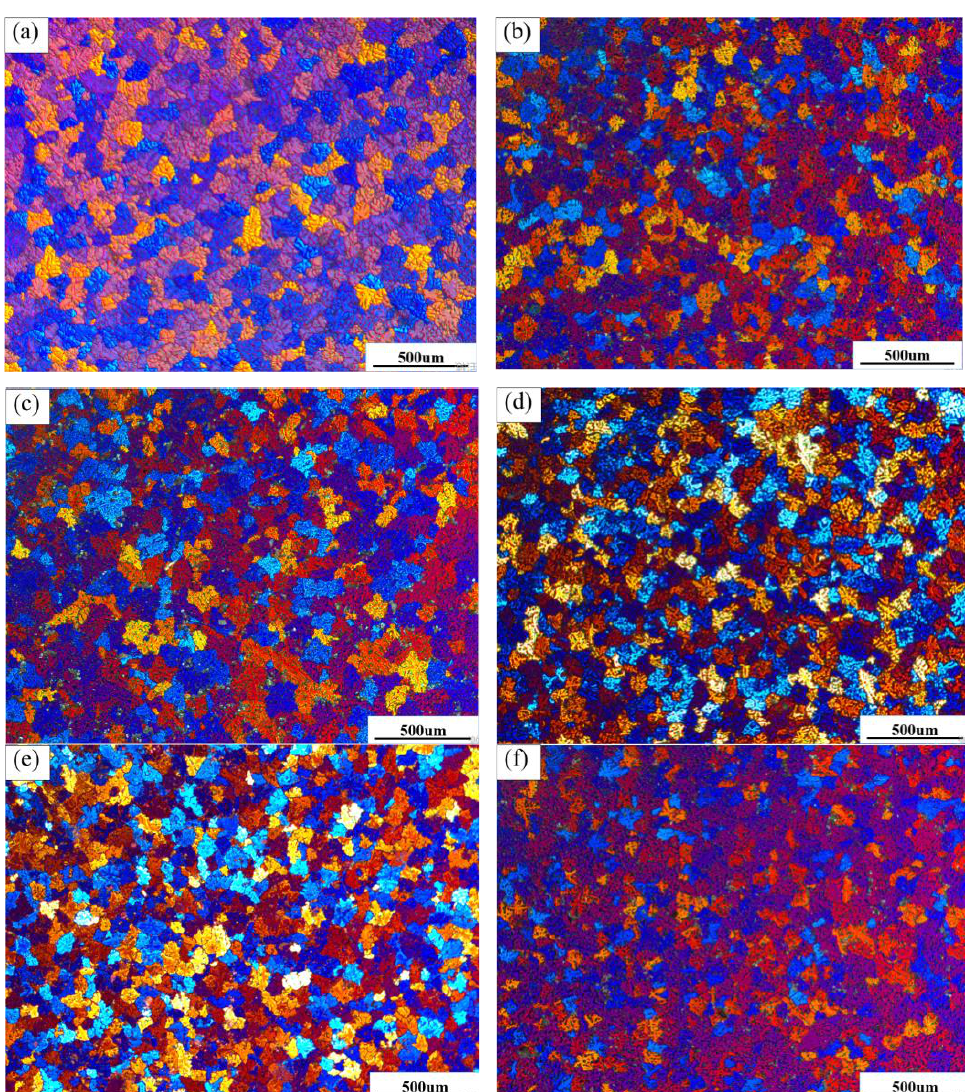
Figure 1. Polarized images of the ZL205 alloy after the addition of the 0.3 wt% Al – TiO 2 – C – X Er 2 O 3 refiner. ( a ) ZL205 alloy; ( b ) X = 0; ( c ) X = 2; ( d ) X = 4; ( e ) X = 6; ( f ) X = 8.